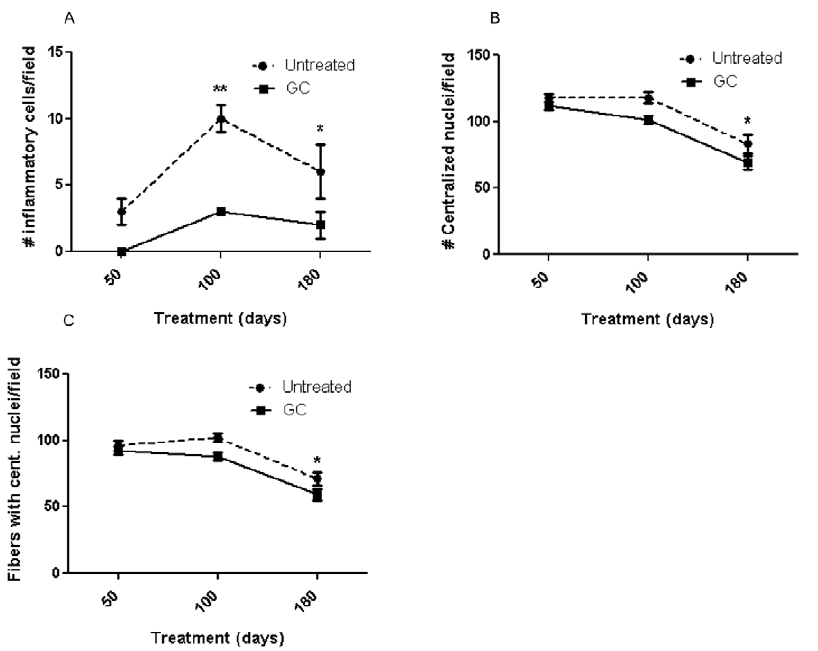
Figure 4. Hematoxylin and eosin (H & E) evaluation of skeletal muscle. H&E staining was carried out to assess the effect of treatment on inflammation ( A ), central nucleation ( B ), and fibers with central nucleation ( C ). Inflammatory cells were quantified in five non-overlapping fields in gastrocnemius muscle. mdx mice received no treatment (N=4, 15, and 15) or GC treatment (N=4, 18, and 16) for 50, 100, or 180 days, respectively. Error bars indicate mean + /- SEM. * p = , 0.05 and ** p = ,